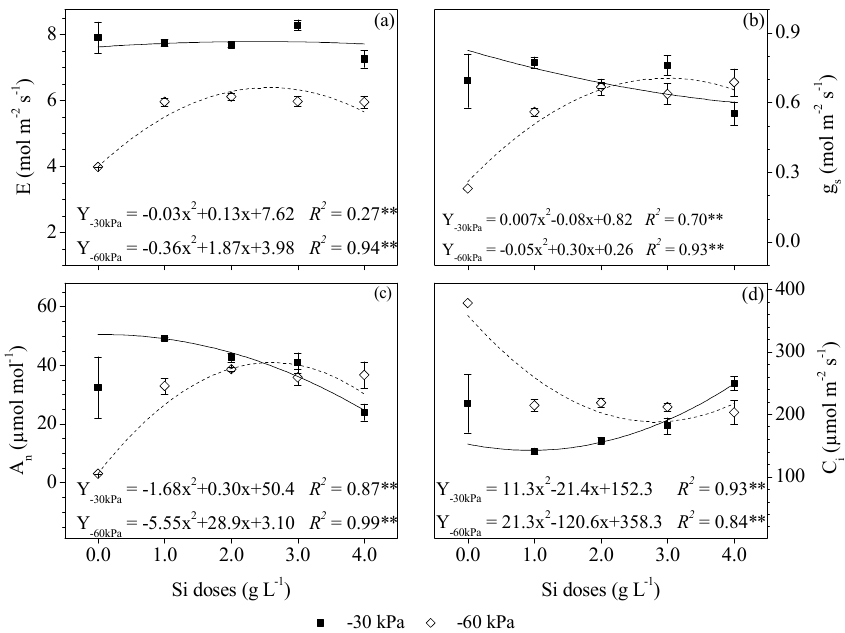
Figure 3. Responses of transpiration rate ( a ), stomatal conductance ( b ), net photosynthesis assimilation rate ( c ), and internal concentration of CO 2 ( d ) to different amount of Si (g L − 1 ) subjected to two levels of water restriction ( − 30 and − 60 kPa) at 20 DAT. (**) significant at 1% by F test.